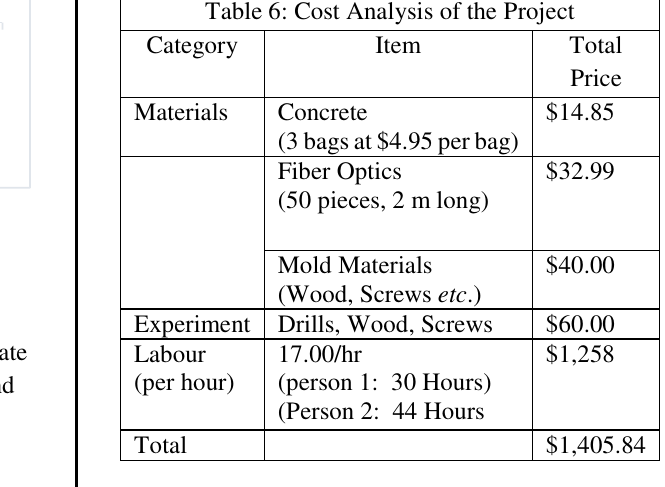
Table 6: Cost Analysis of the